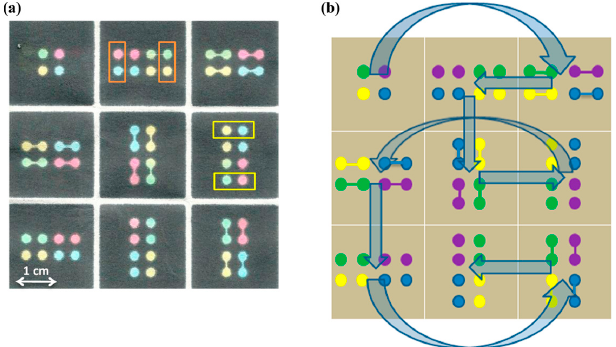
Figure 6. The paper-based 3D- μ PADs designed in [115]. ( a ) The yellow rectangles of the unfolded μ PADs marked out the protein detection region while the orange rectangles for glucose; ( b ) Flow pattern of the developed 3D- μ PADs. Sample flow was introduced from the corner at the top left and spread into the middle square at the bottom layer. With the permission from [115]; Copyright 2013, American Chemical Society.